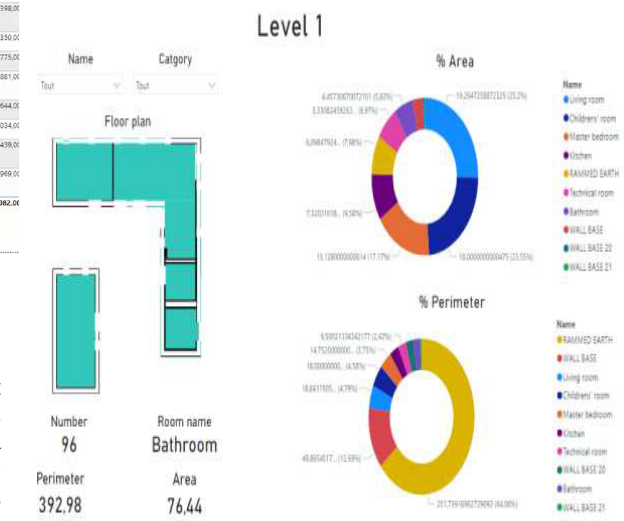
Figure 9. 2D d rawings extraction